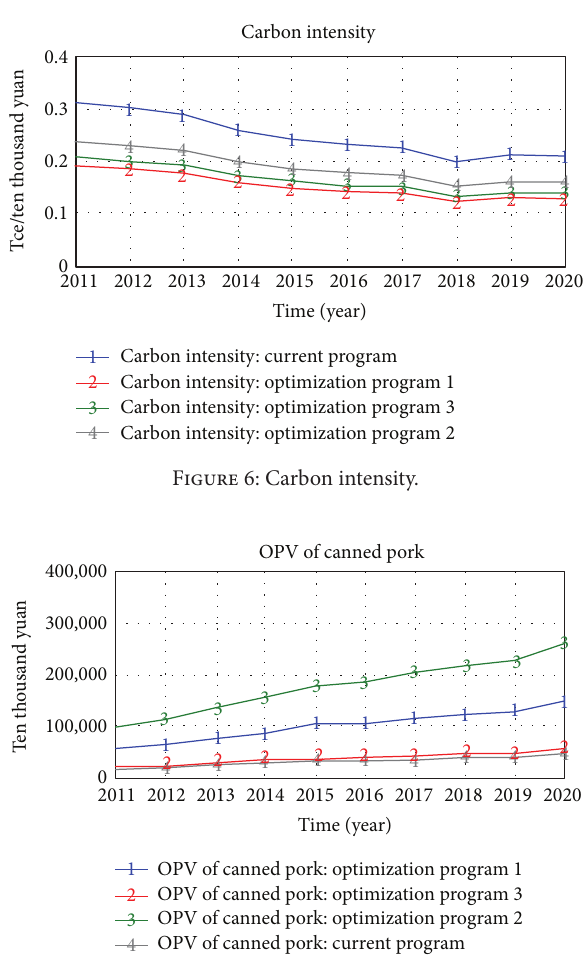
Figure 7: The output value of canned pork.